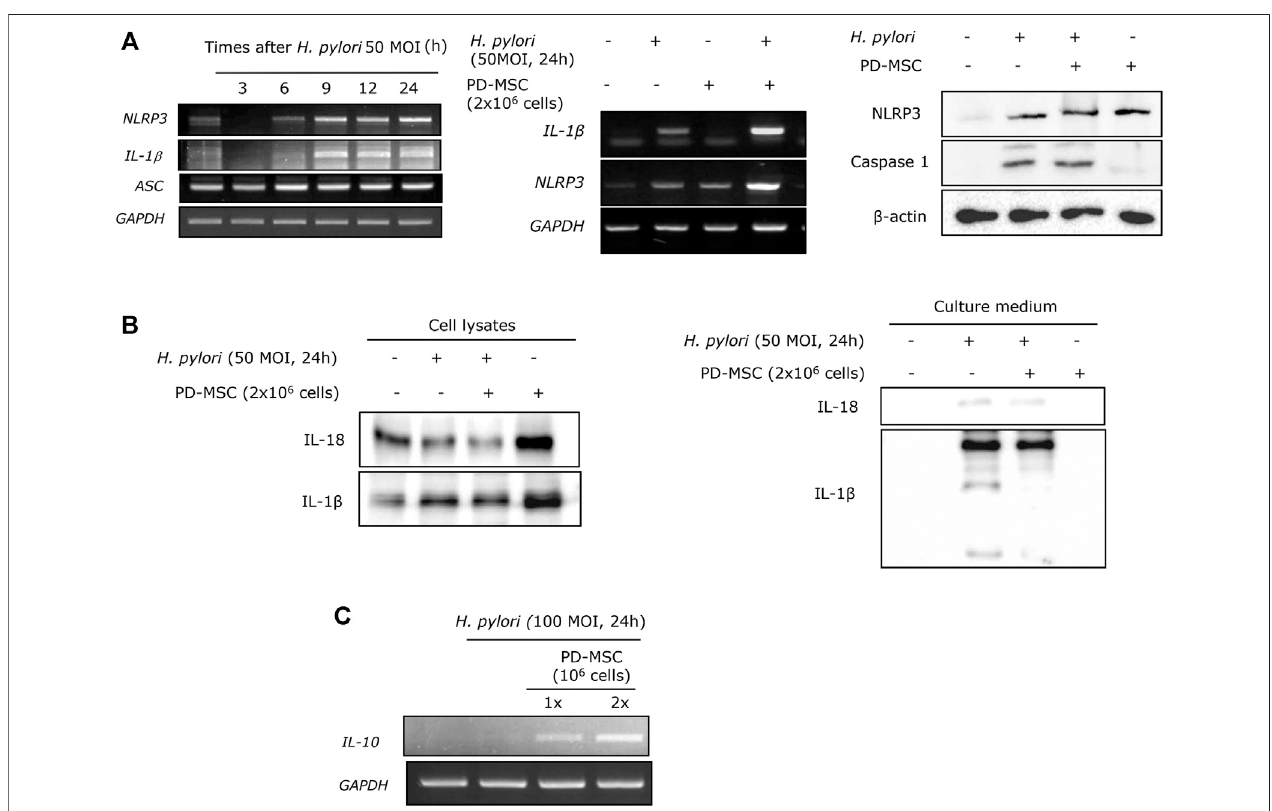
FIGURE 6 | In fl ammasomes relevant to H. pylori infection and PD-MSC in fl uence. (A) Left: RT-PCR for NLRP3 , IL-1 β , and ASC . RT-PCR for IL-1 β and NLRP3 mRNA was repeated in the presence of PD-MSCs in RGM-1 cells using a transwell co-culture system. Right: western blot for NLRP3 and caspase-1 in the presence of PD-MSCs. (B) Western blot for IL-1 β and IL-18 in cell lysate and cultured media in the presence of PD-MSCs. (C) IL-10 expressions according to PD-MSC RT-PCR for IL-10mRNA. (D) IL-1 β expressionunder H.pylori inthepresenceofPD-MSCs. (E) Left:IL-1 β foldchangesunder H.pylori inthepresenceofPD-MSCs;right:IL-1 β ELISAlevelsunder H.pylori inthepresenceofPD-MSCs. (F) Upper:RT-PCRfor MMP-2 ;lower:zymographyforMMP-2. (G) ProteinarrayforMMP-2.Alldatarepresent mean ± SD ( n (cid:1) 10).